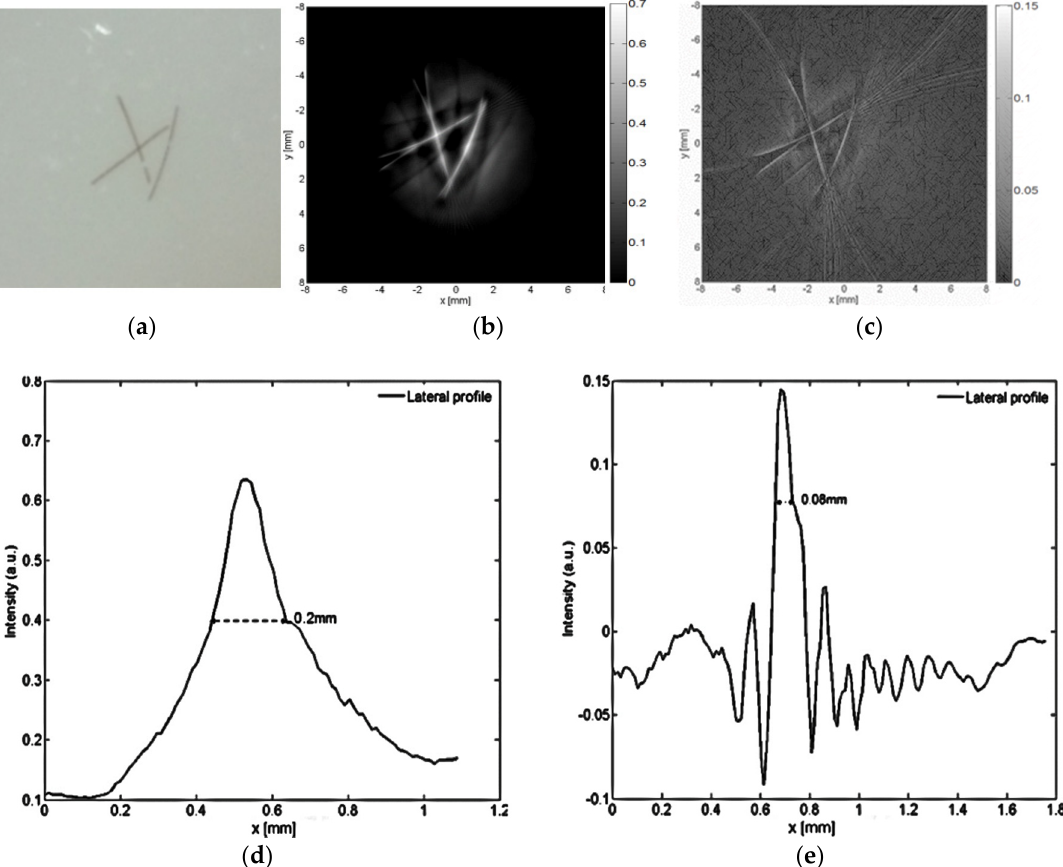
Figure 2. Photograph of the phantom used for the phantom test ( a ); the photoacoustic (PA) images recovered by using the 10 MHz unfocused transducer ( b ) and focused one ( c ). The imaging profiles were plotted along the center of one hair for the unfocused transducer ( d ) and focused one ( e ). The axis (bottom) denotes the spatial scale in mm whereas the axis (left) records the PA signals in a relative unit.